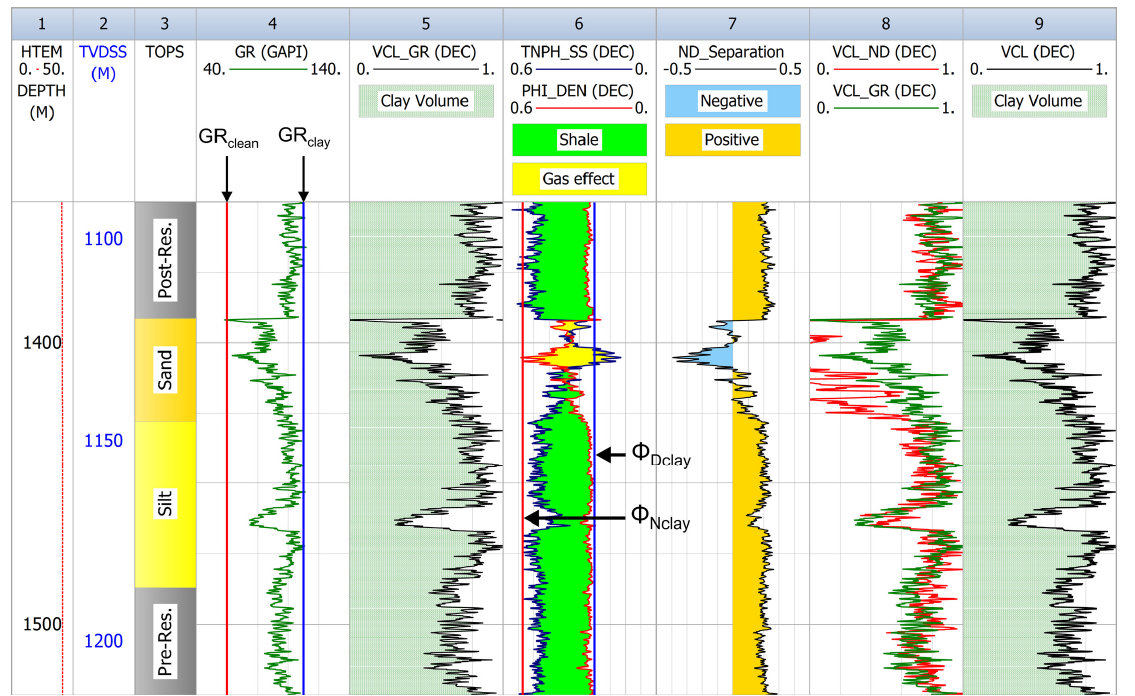
Figure 7. Clay volume derived from GR log (track 4) and from the neutron–density logs combination (track 6). V clayGR (track 5) is referenced against the φ Nclay − φ Dclay separation (tracks 6 and 7) to provide V clayGR ≈ V clayND in the shaly water-bearing intervals (track 8) and is used as the final clay indicator (track 9). TNPH_SS is the matrix-corrected (sandstone) neutron